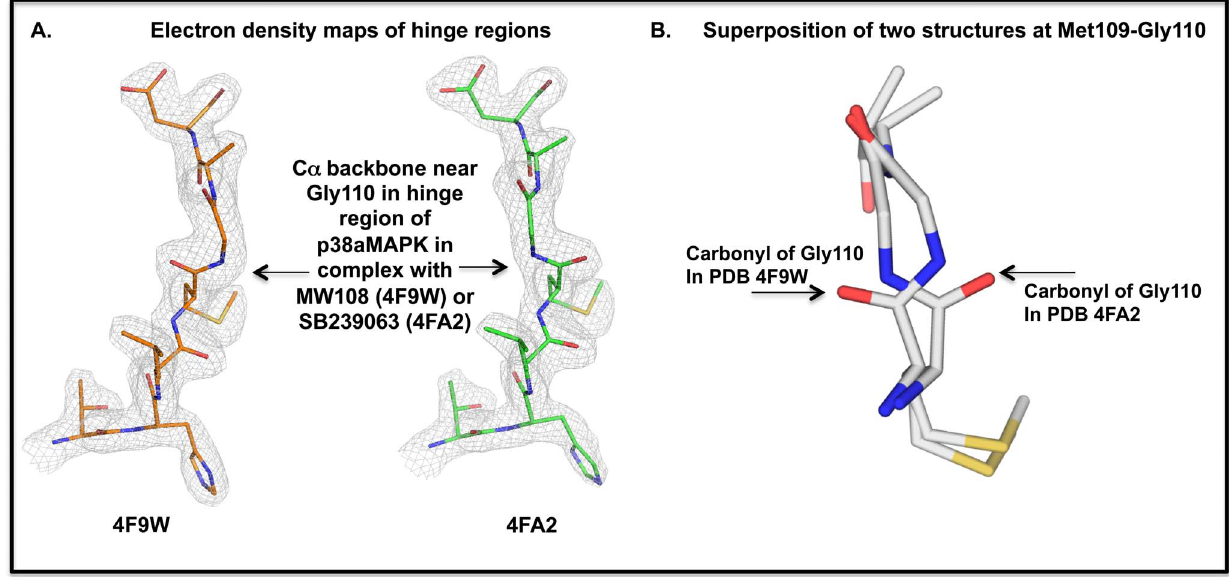
Figure 5. Localized conformational change in the hinge region of human p38 a MAPK when a non-selective inhibitor is bound. A. Electron density maps (2mFo-Dfc; colored in light gray) contoured at 1.5 rmsd for the hinge region of p38 a MAPK near Gly110 for 4F9W (in complex with MW108) and for 4FA2 (in complex with SB239063) are shown. Differences in the electron density path are seen in the area around Gly110, indicated by arrows. B. A superposition of 4F9W and 4FA2 reveals the differences around the peptide bond at Met109-Gly110, referred to as a